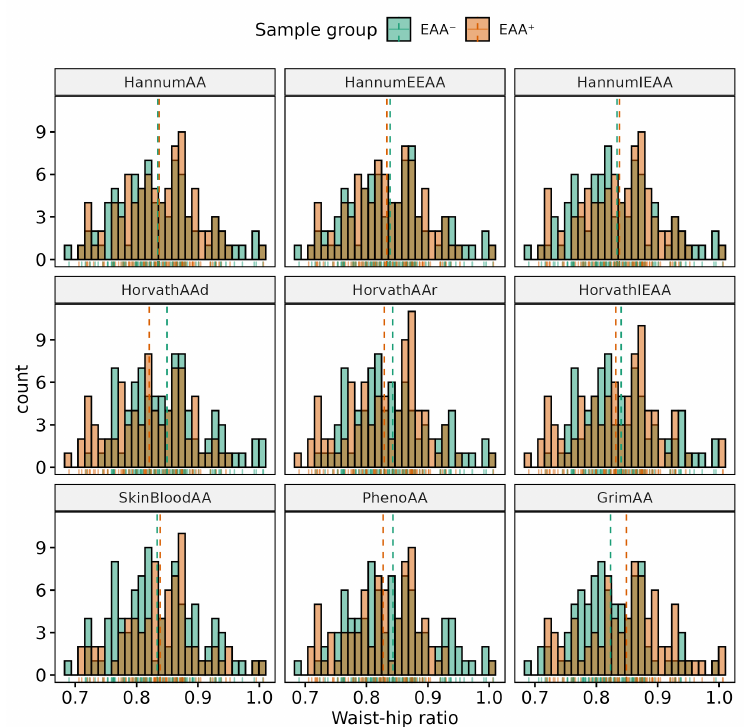
Figure A6. Histograms of distributions of waist–hip ratio in females in EAA + and EAA − groups. Dashed lines correspond to the group